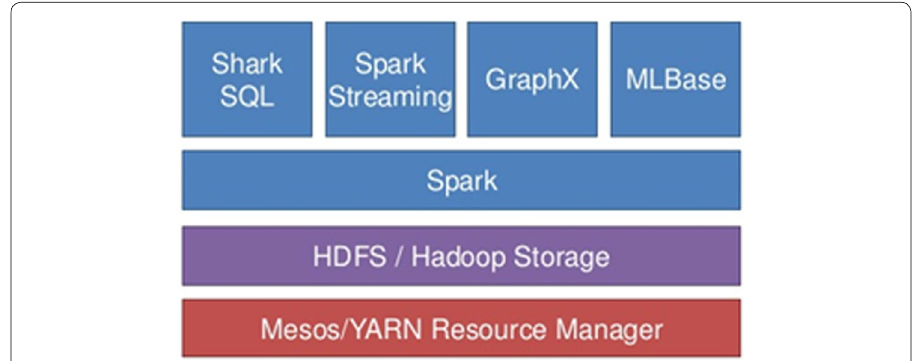
Fig. 2 Spark ecosystem and components. Spark ecosystem on Hadoop and Spark main